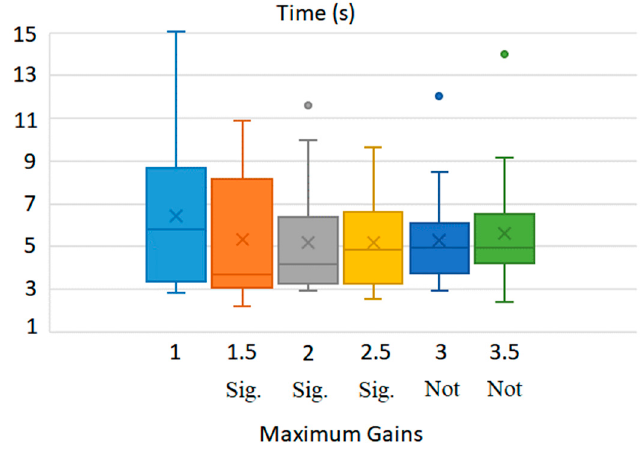
Figure 4. Task completion times based on the maximum gains (the line in the boxplot is the median value and the cross mark is the mean value). Table 2. Mean task completion times with standard deviation values and results of Wilcoxon signed-rank test.